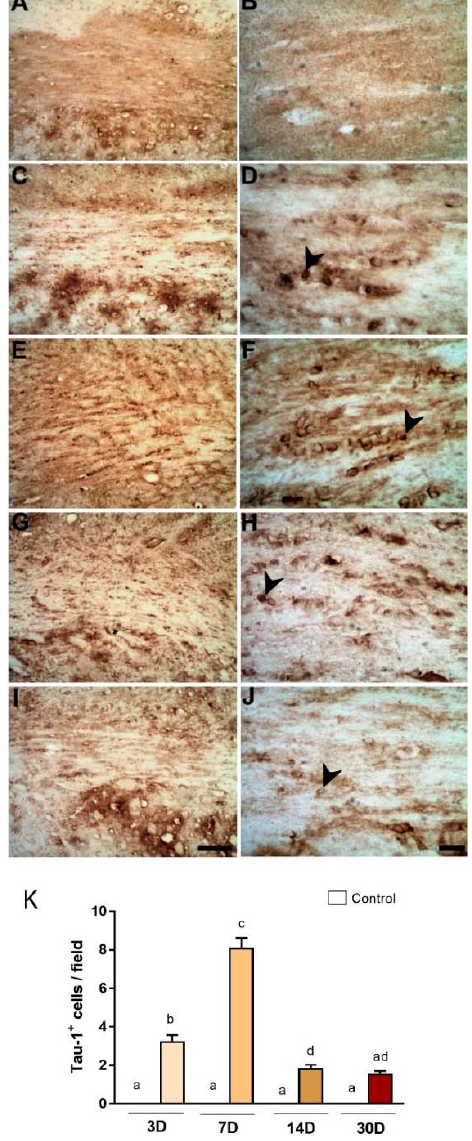
Figure 4. Increased pathological oligodendrocytes in the corpus callosum after striatal. Photomi- crographs represent control animal injected with sterile saline ( A , B ) or ischemic animals injected with ET-1 at 3 ( C , D ); 7 ( E , F ); 14 ( G , H ); and 30 ( I , J ) PLDs. The results of quantitative analysis ( K ) are expressed as mean ± standard error of the mean (SEM). One-way ANOVA with Tukey’s post-hoc test ( p < 0.05). Similar overwritten letters did not show significant statistical differences. Arrowheads point to TAU-1 + cells (pathological oligodendrocytes). Left-sided photomicrographs in lower magni- fication with a scale bar of 20 µ m, and right-sided ones, with higher magnification with a scale bar of 100 µ